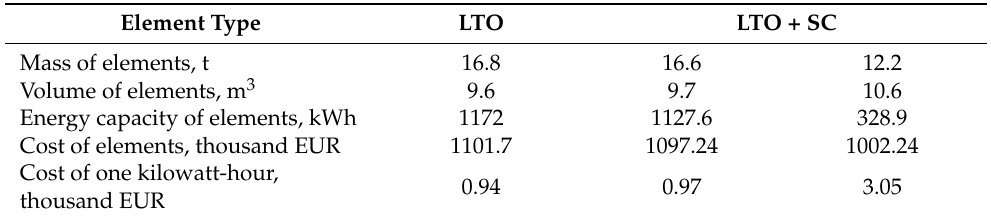
Table 4. Comparison of options.